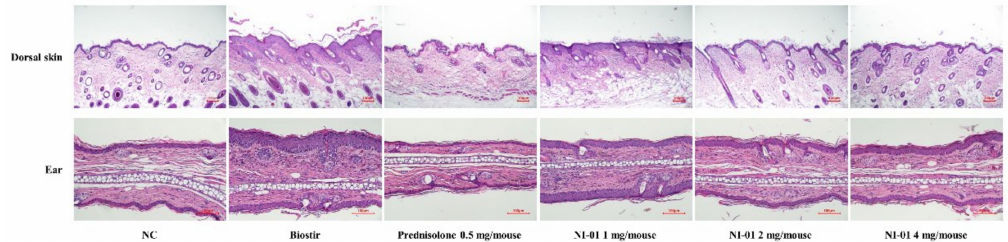
Figure 5. E ff ect of NI-01 on histological features of dorsal skin and ear lesions in house dust mite treated NC / Nga mice. Dorsal skin and ear tissue were fixed with 4% paraformaldehyde, embedded in para ffi n and cut into thin sections. Histological features of lesions were determined with hematoxylin and eosin ( × 20). Prednisolone was used as a positive control. NC; normal control, Biostir; Biostir-AD ®